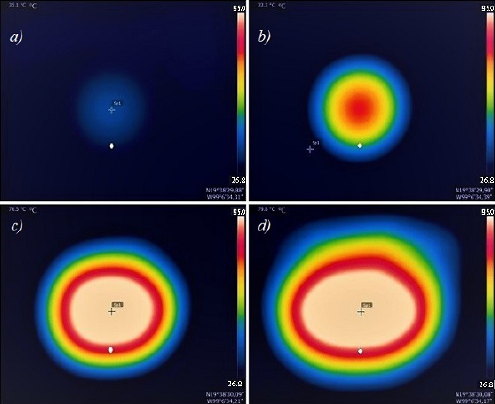
Figure 11. Thermographies during the transient stage of growth of the steam chamber: ( a ) thermog- raphy taken at t = 10 s after the injection start-up, ( b ) t = 120 s, ( c ) t = 360 s, and ( d ) t = 900 s. The white point indicates the position of the recovery orifice.